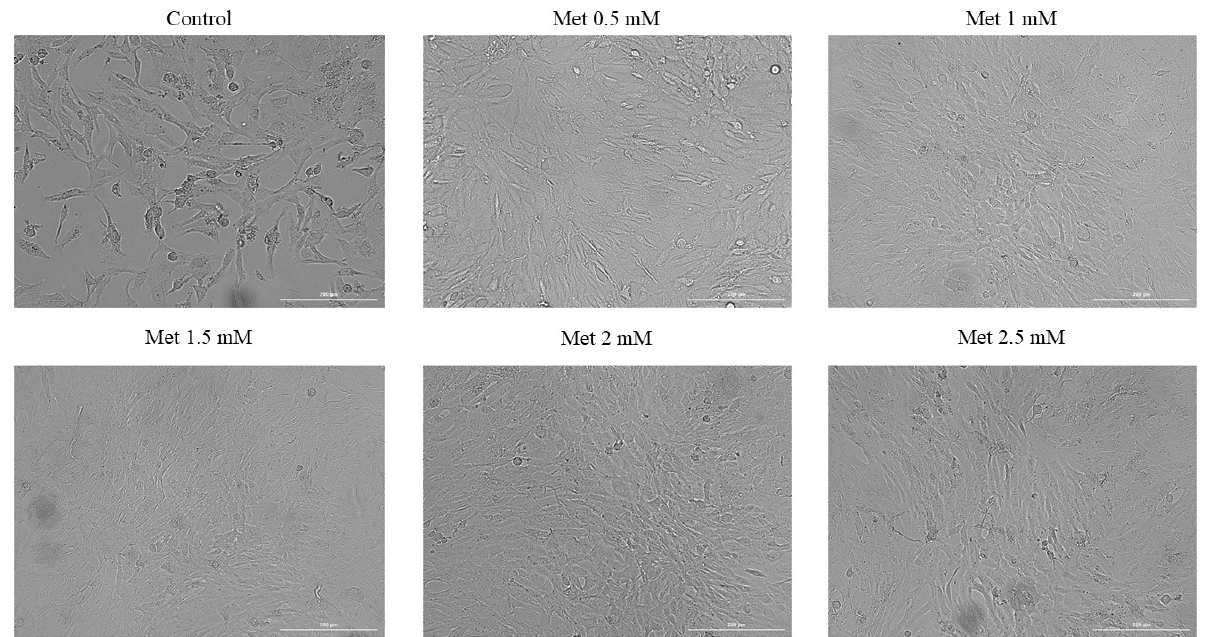
Figure 4. Morphology and confluence of HepaRG cells following the 72 h treatment with Met 0.5, 1, 1.5, 2 and 2.5 mM. The scale bars indicate 200 μ m.